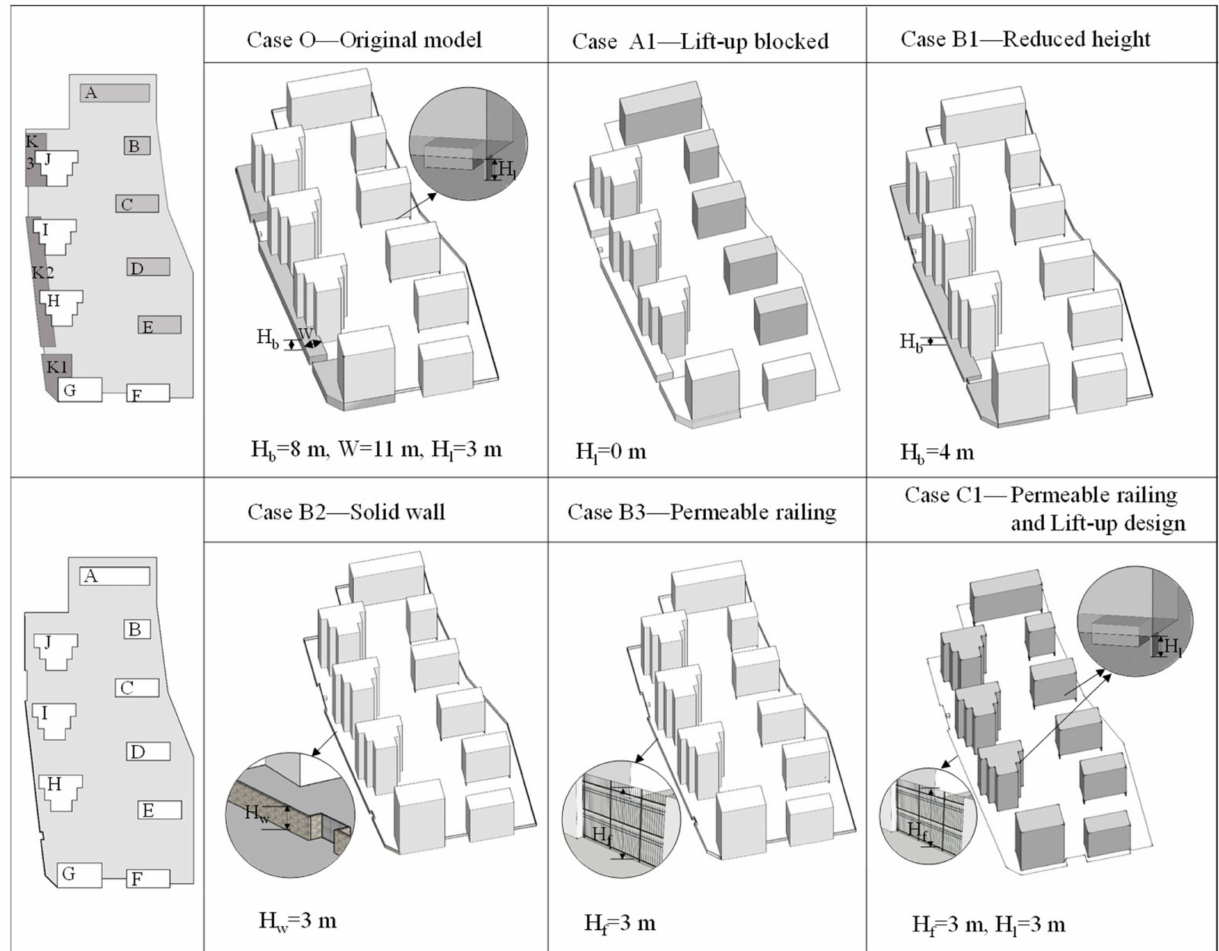
Figure 9. Design of the six